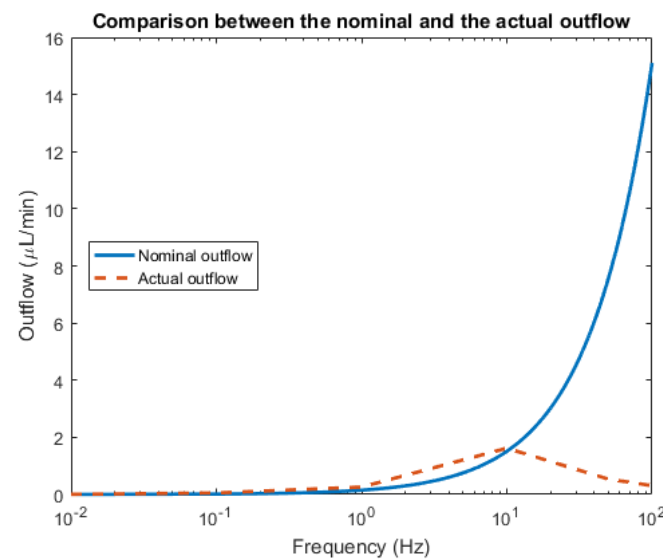
Figure 5. The dependency of the outflow on the pumping